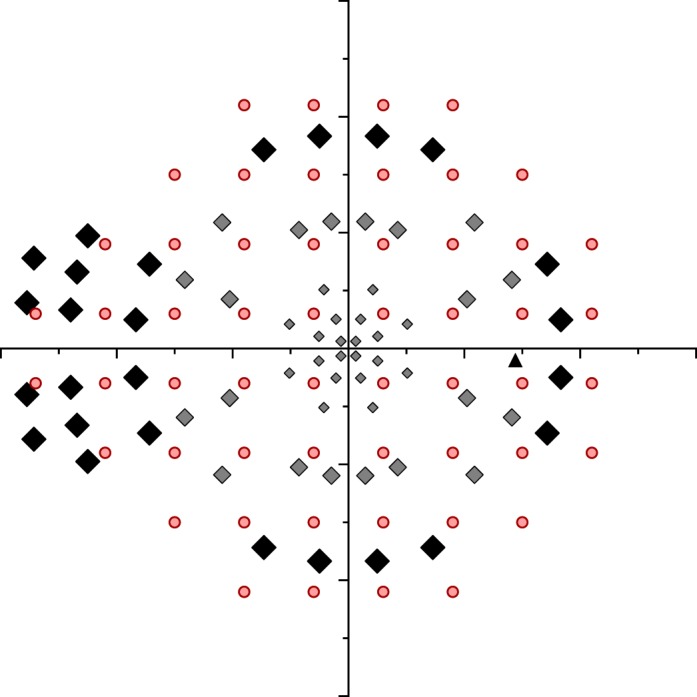
Locations used for testing the Right eye by the MRF (small gray diamonds, macula: medium gray diamonds, paramacula: large black diamonds, peripheral 30°) compared against the HFA 24-2 pattern (circles). The blind spot location is shown as a black triangle. The variable size of the MRF test spot has been shown schematically by increasing the symbol size and is not accurately scaled.